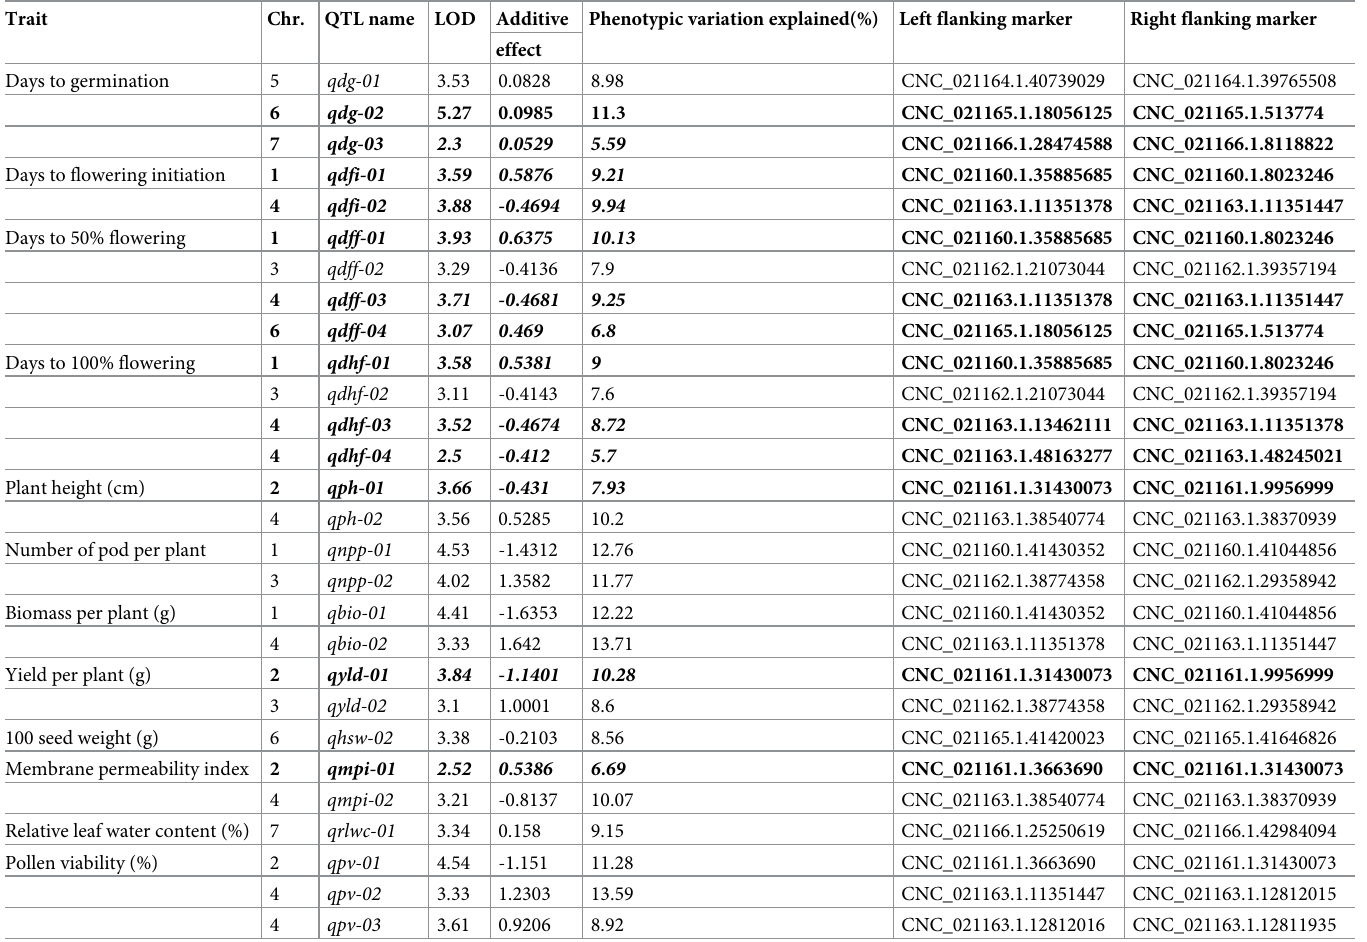
Table 2. Summary of the QTLs associated with the heat stress related traits at Ludhiana.